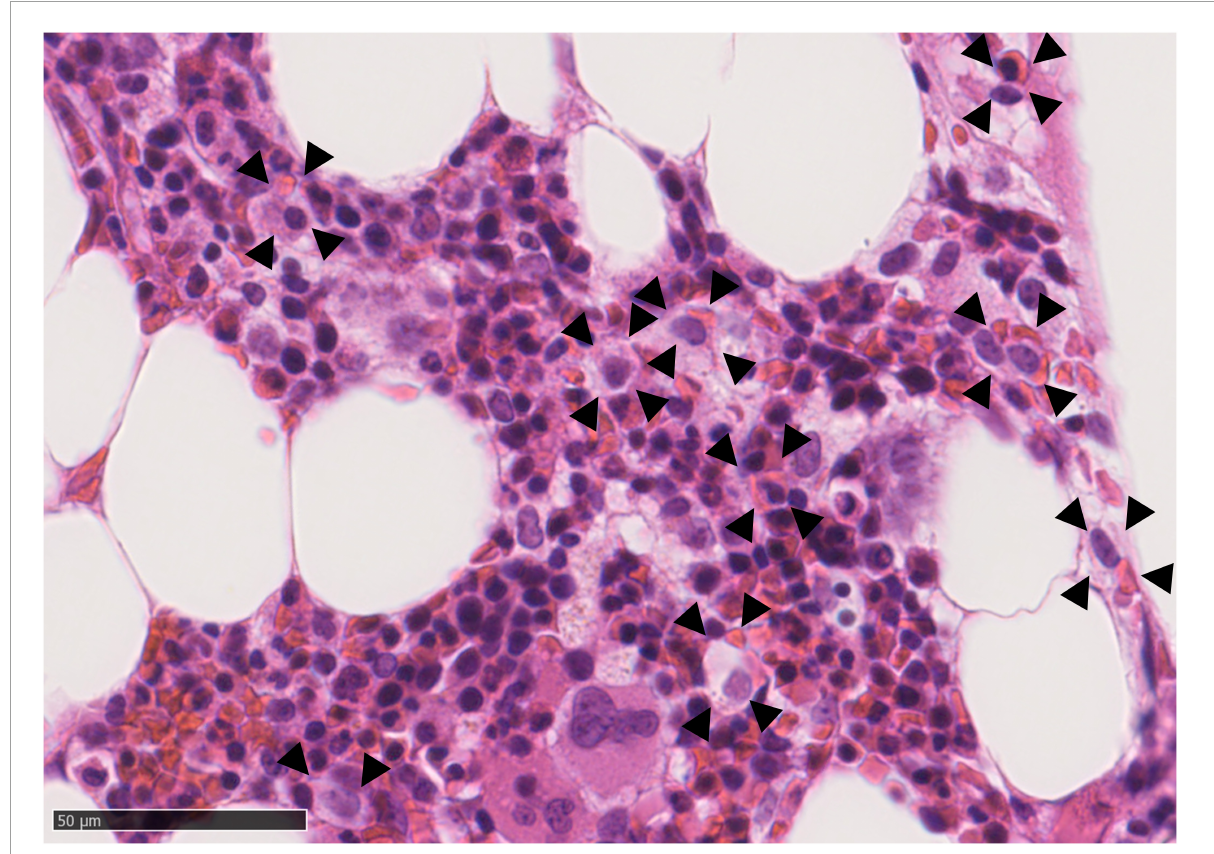
FIGURE1 Bone marrow biopsy (Hematoxylin and Eosin stained, 400 × ) showing histiocytes (arrows) engulfing red blood elements compatible with